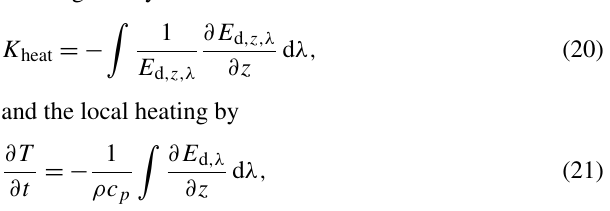
Small phyto. Large phyto. Benthic